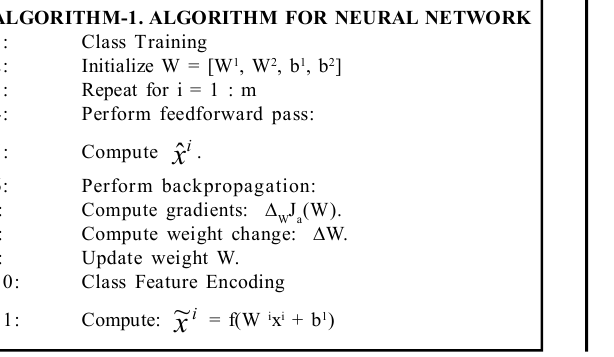
ALGORITHM-1. ALGORITHM FOR NEURAL NETWORK